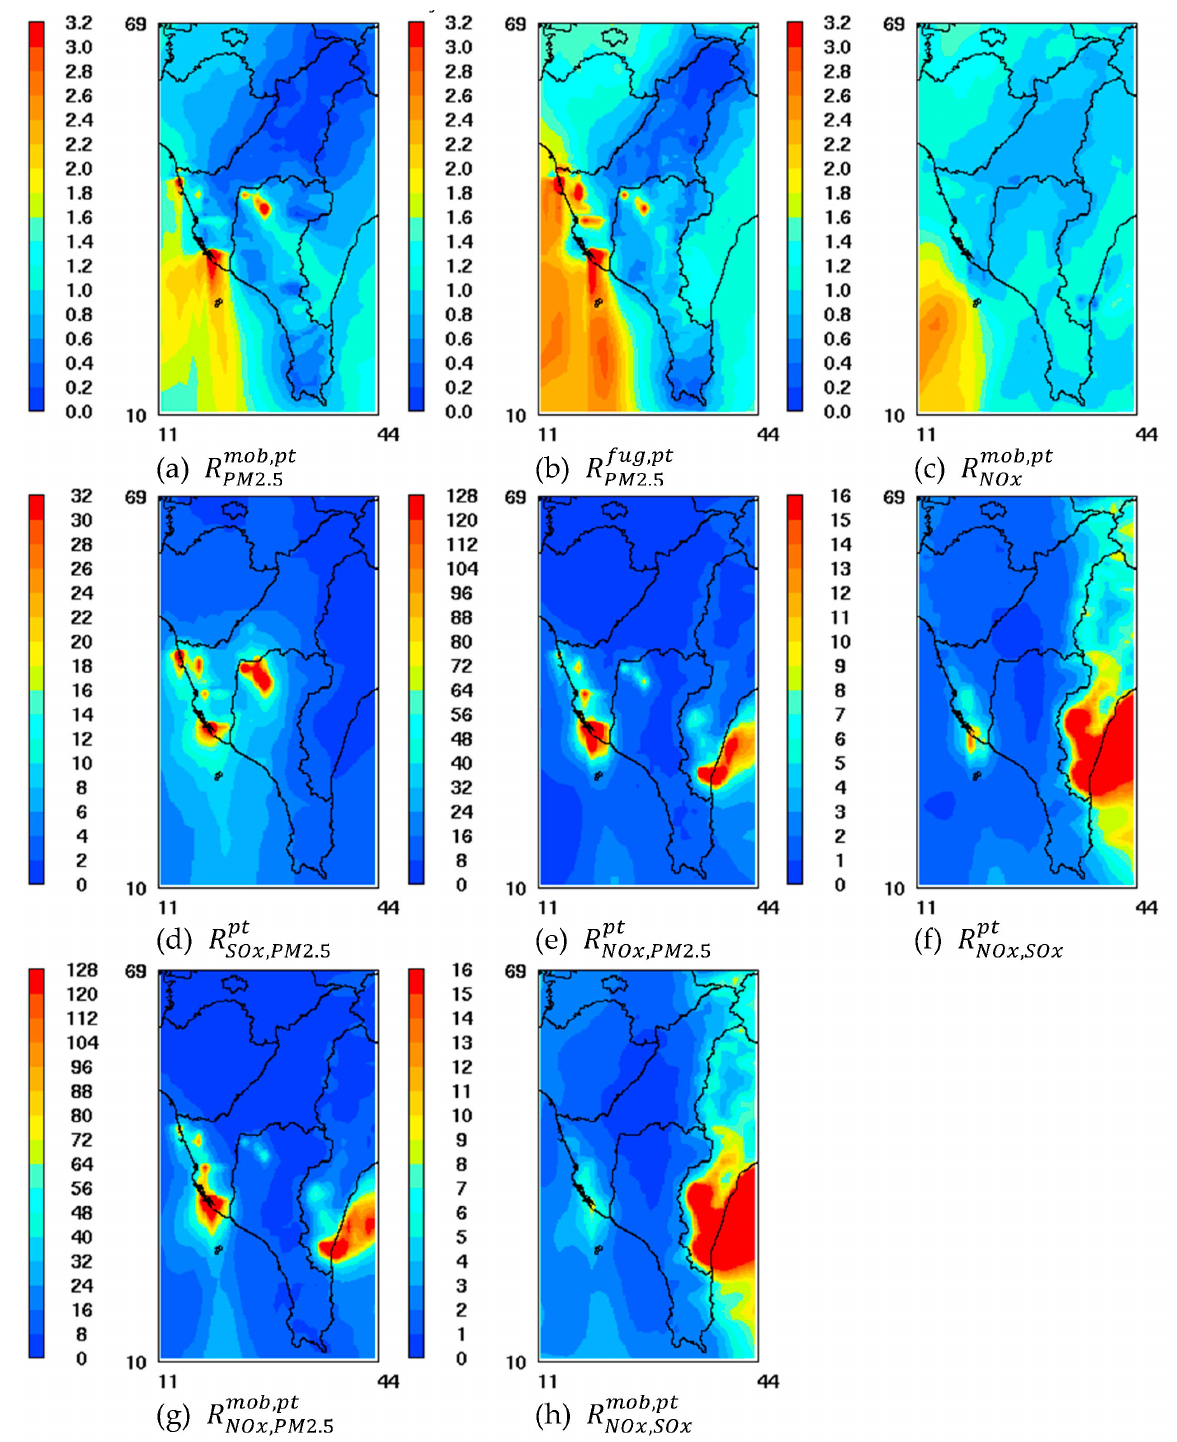
Figure 4. Spatial distribution of the eight needed offset ratios, including ( a ) mobile PM 2.5 - to - point PM 2.5 ratio, ( b ) fugitive PM 2.5 - to - point PM 2.5 ratio, ( c ) mobile NO X - to - point NO X ratio, ( d ) point SO X - to - point PM 2.5 ratio, ( e ) point NO X - to - point PM 2.5 ratio, ( f ) point NO X - to - point SO X ratio, ( g ) mobile NO X - to - point PM 2.5 ratio, and ( h ) mobile NO X - to - point SO X ratio .